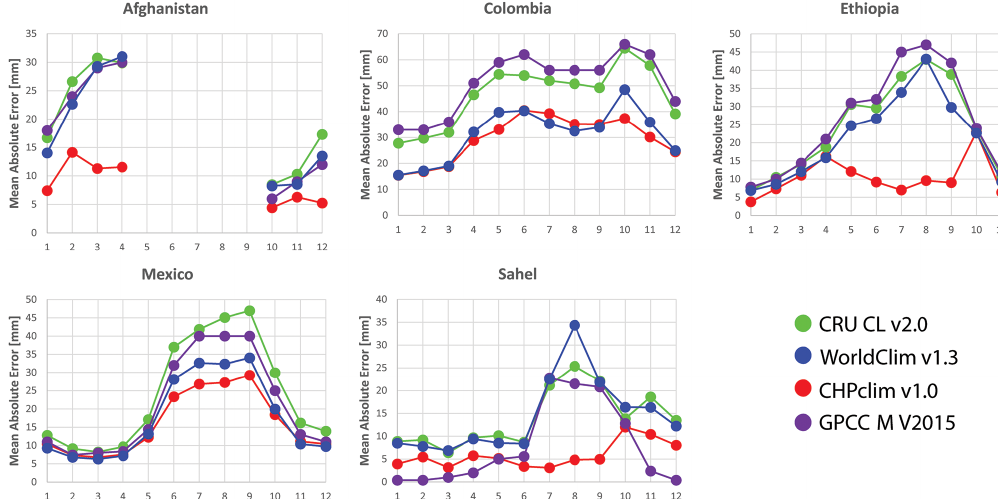
Figure 7. Mean absolute error time series [mmmonth − 1 ].